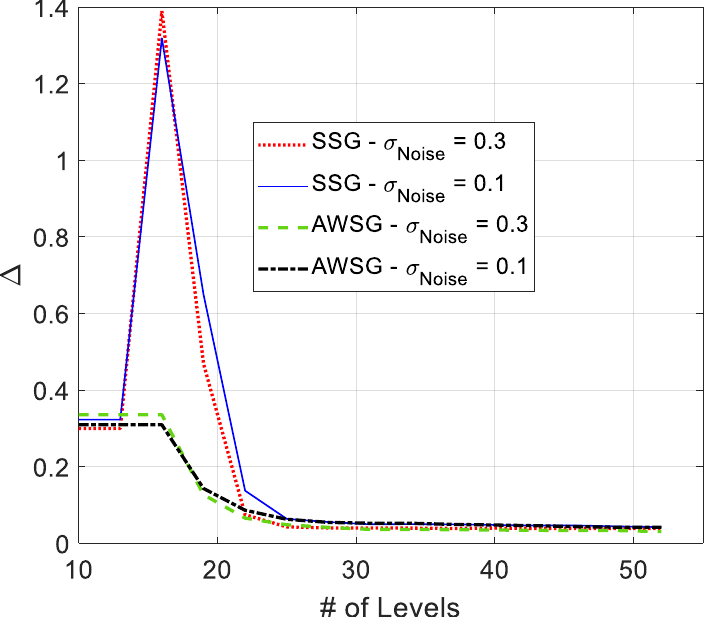
Figure 11. Variation of ∆ in the course of convergence in SSG and AWSG in the presence of filtered observation